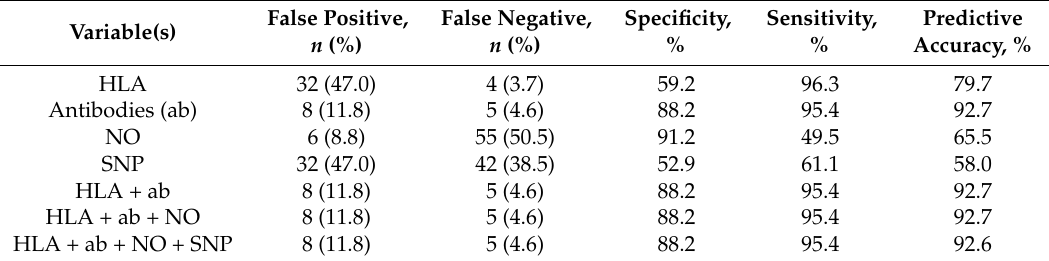
Table 4. Results of the discriminant analyses showing sensitivity, specificity, and the predictive accuracy, when using different numbers of variables.